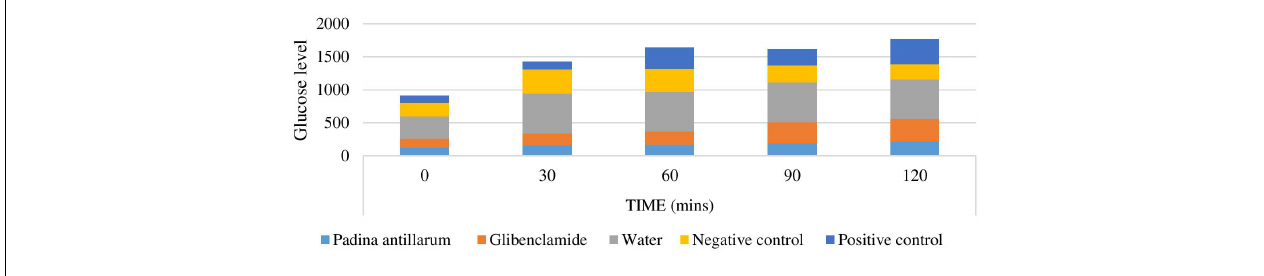
FIGURE 11 | Oral glucose test of the